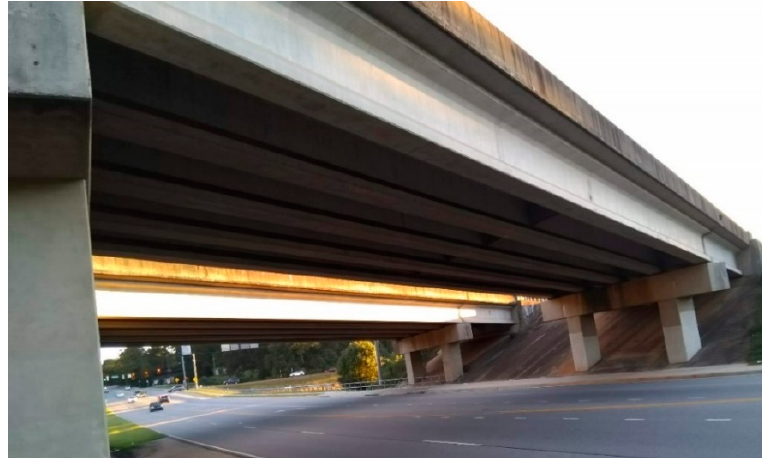
Figure 2. Typical bridge in the ‘PC109’ group.